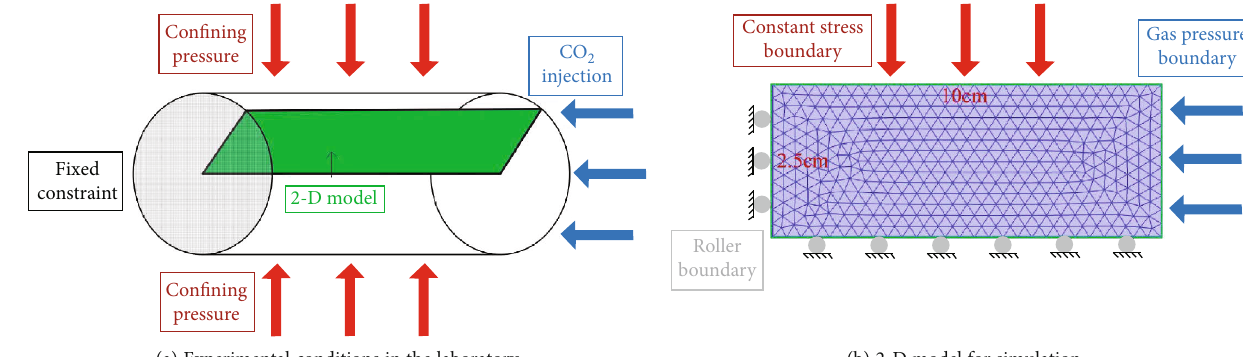
Figure 6: The model used in the validation.